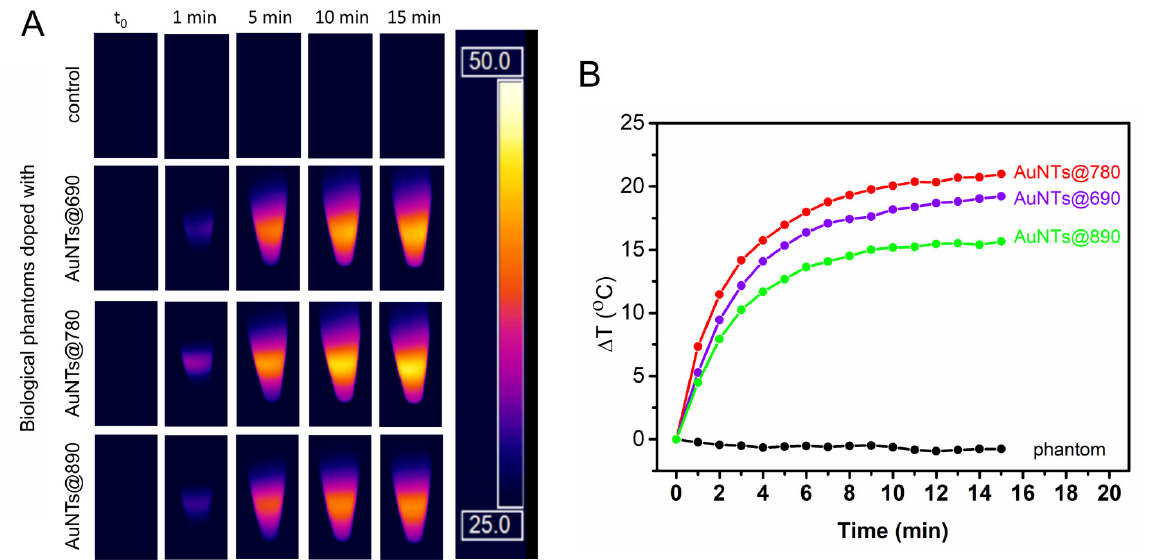
Figure 4. ( A ) The thermographic images of AuNTs doped biological phantoms during the irradiation with a 785 nm laser for 15 min and ( B ) the extracted corresponding thermal curves.